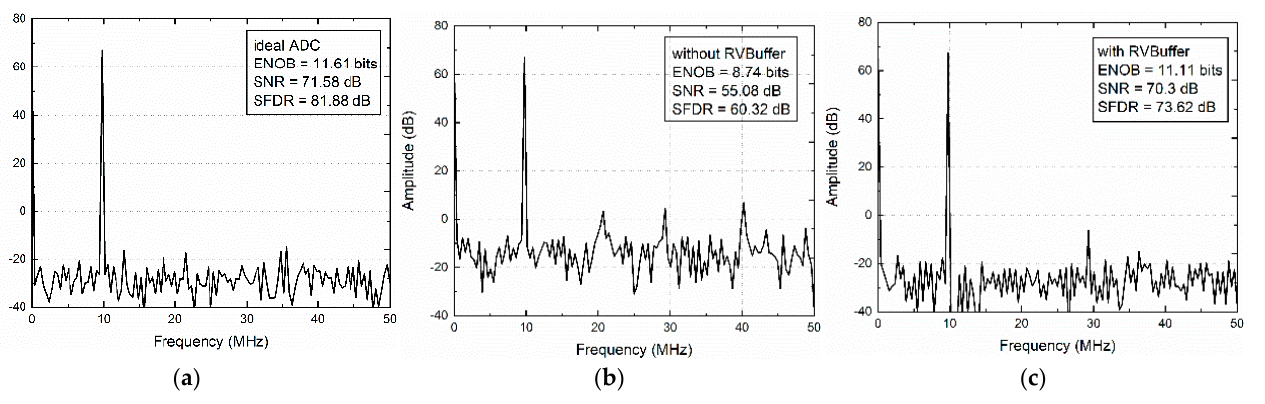
Figure 11. ( a ) The chip photograph with detailed layout; ( b ) power breakdown.